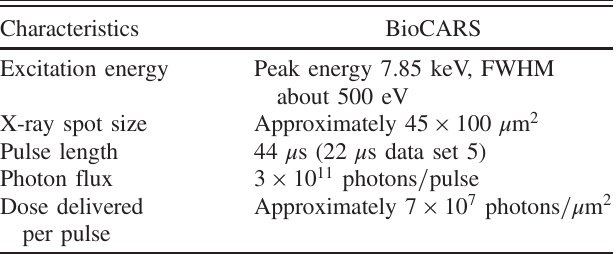
TABLE I. Experimental characteristics of the pulsed x-ray source.